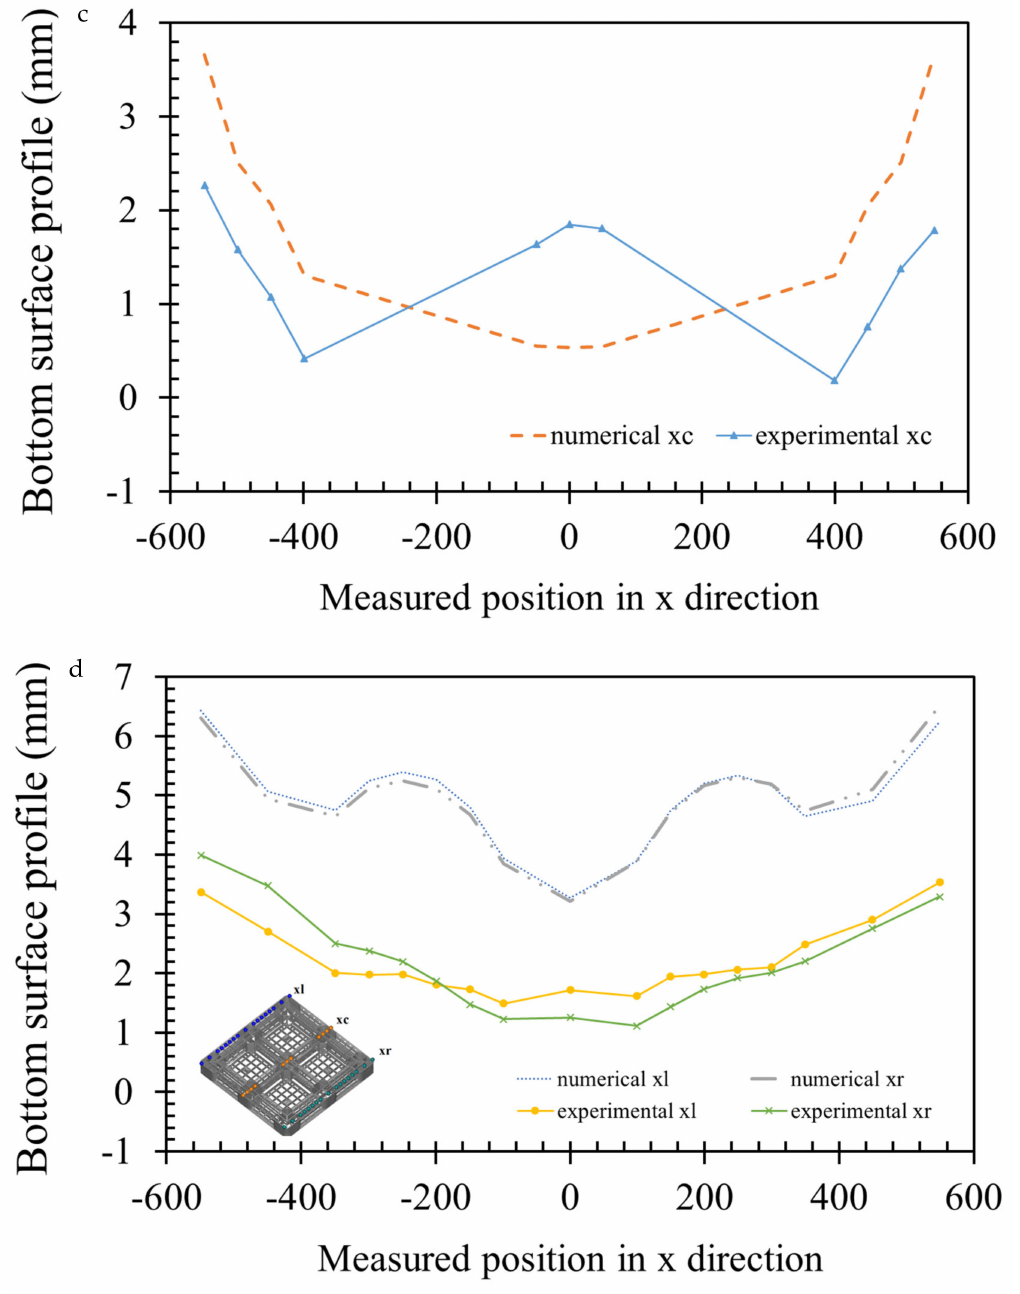
Figure 13. ( a ) Bottom side height profile measurement points in the x-axis direction of the pallet; ( b ) bottom side height profile measurement points in the y-axis direction of the pallet; ( c ) comparison of the simulated and actual heights of the bottom central part of the pallet in the x-axis direction; ( d ) comparison of the simulated and actual bottom side height profiles of both sides of the pallet in the x-axis